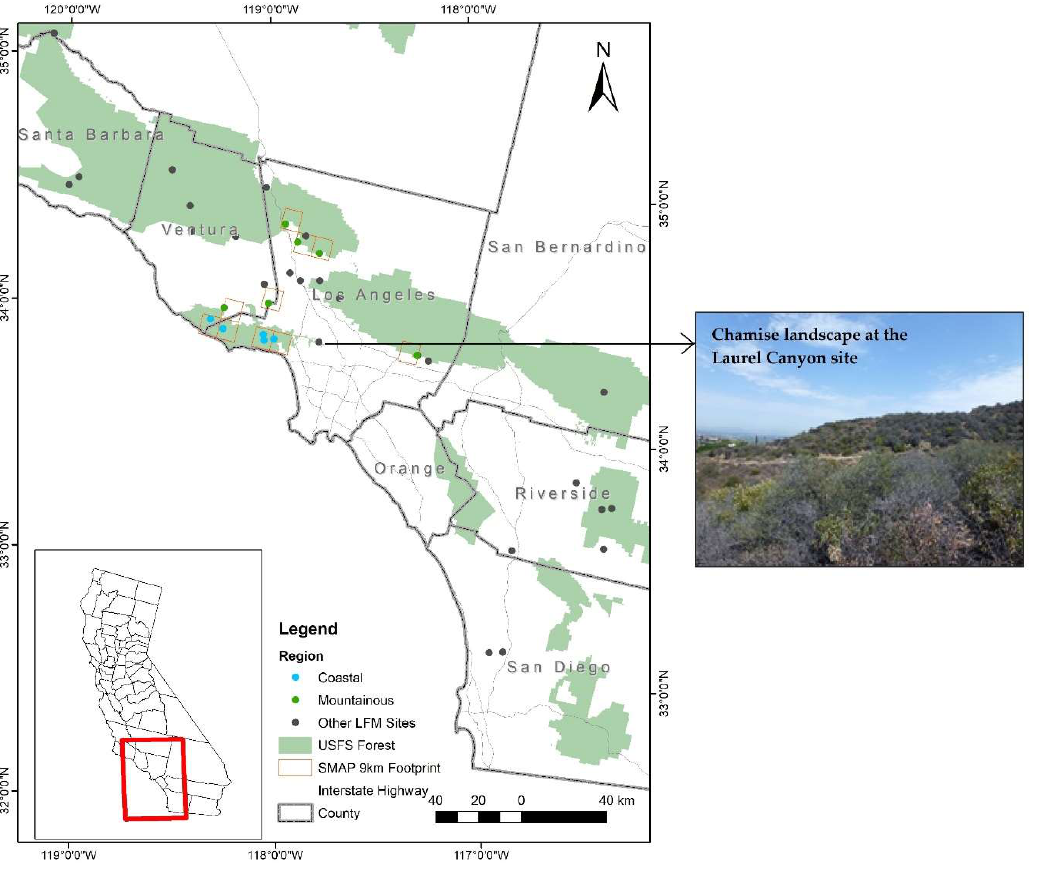
Figure 2. Active live fuel moisture (LFM) observation sites and chamise landscape in Southern California. Blue and green dots in the map are sites used in the study, representing coastal and mountainous sites. Grey dots in the map are other sites with data available. Photo shows the landscape of the chamise at the Laurel Canyon site, maintained by Los Angeles County Fire Department.